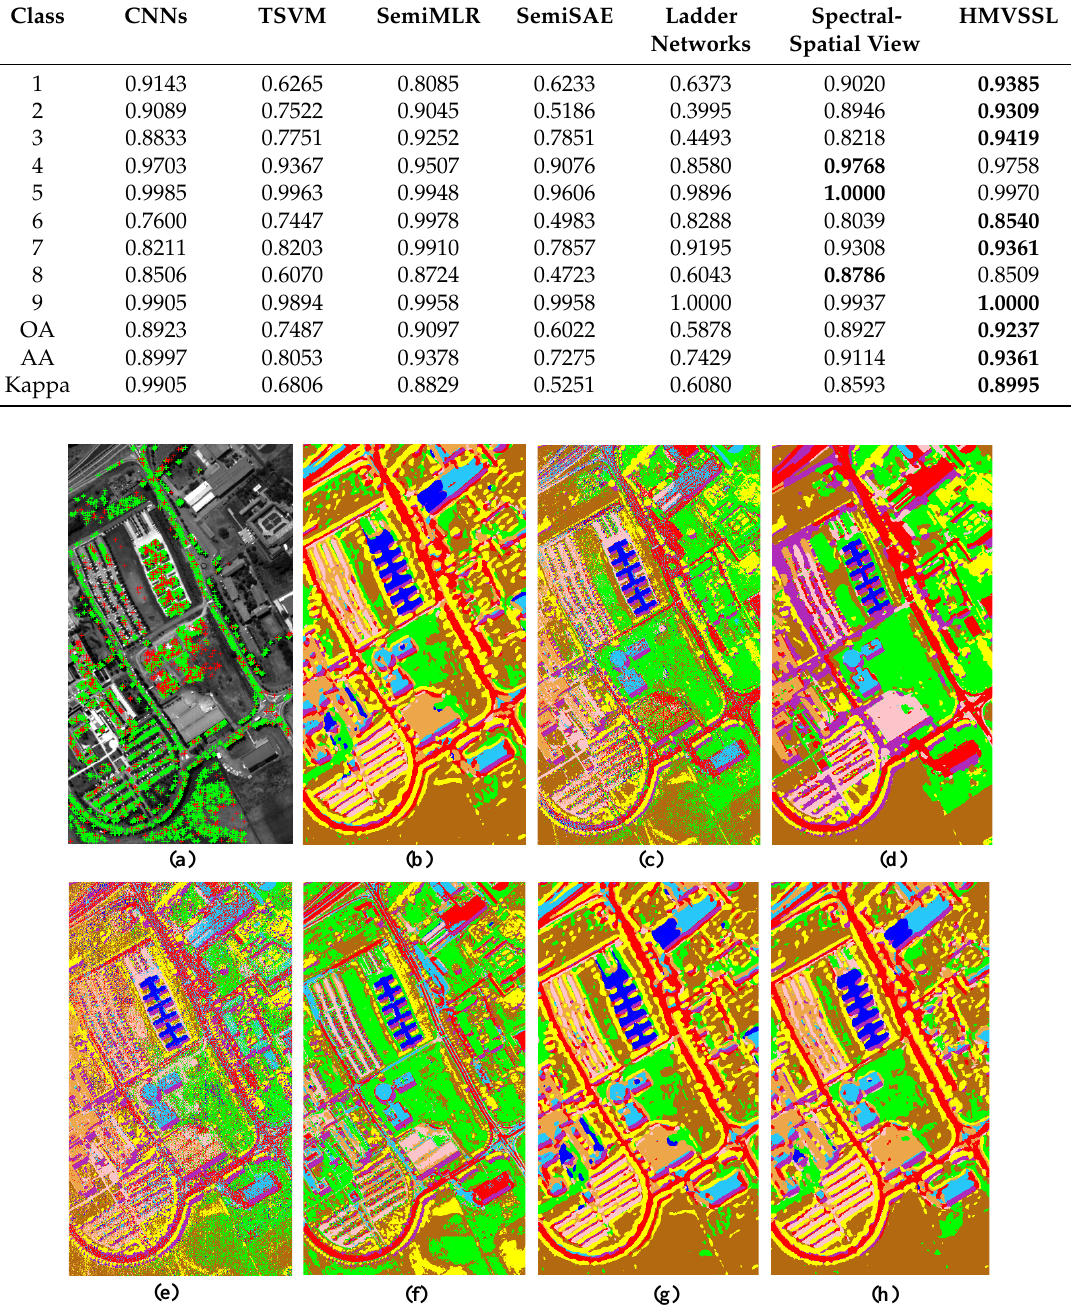
Figure 12. Classification results of the compared methods for Pavia University data: ( a ) Selected training samples (red markers are the initial selected training points, and the green markers are the final selected training points). ( b ) CNNs. ( c ) TSVM. ( d ) SemiMLR. ( e ) SemiSAE. ( f ) Ladder network. ( g ) Spectral-spatial view. ( h ) HMVSSL